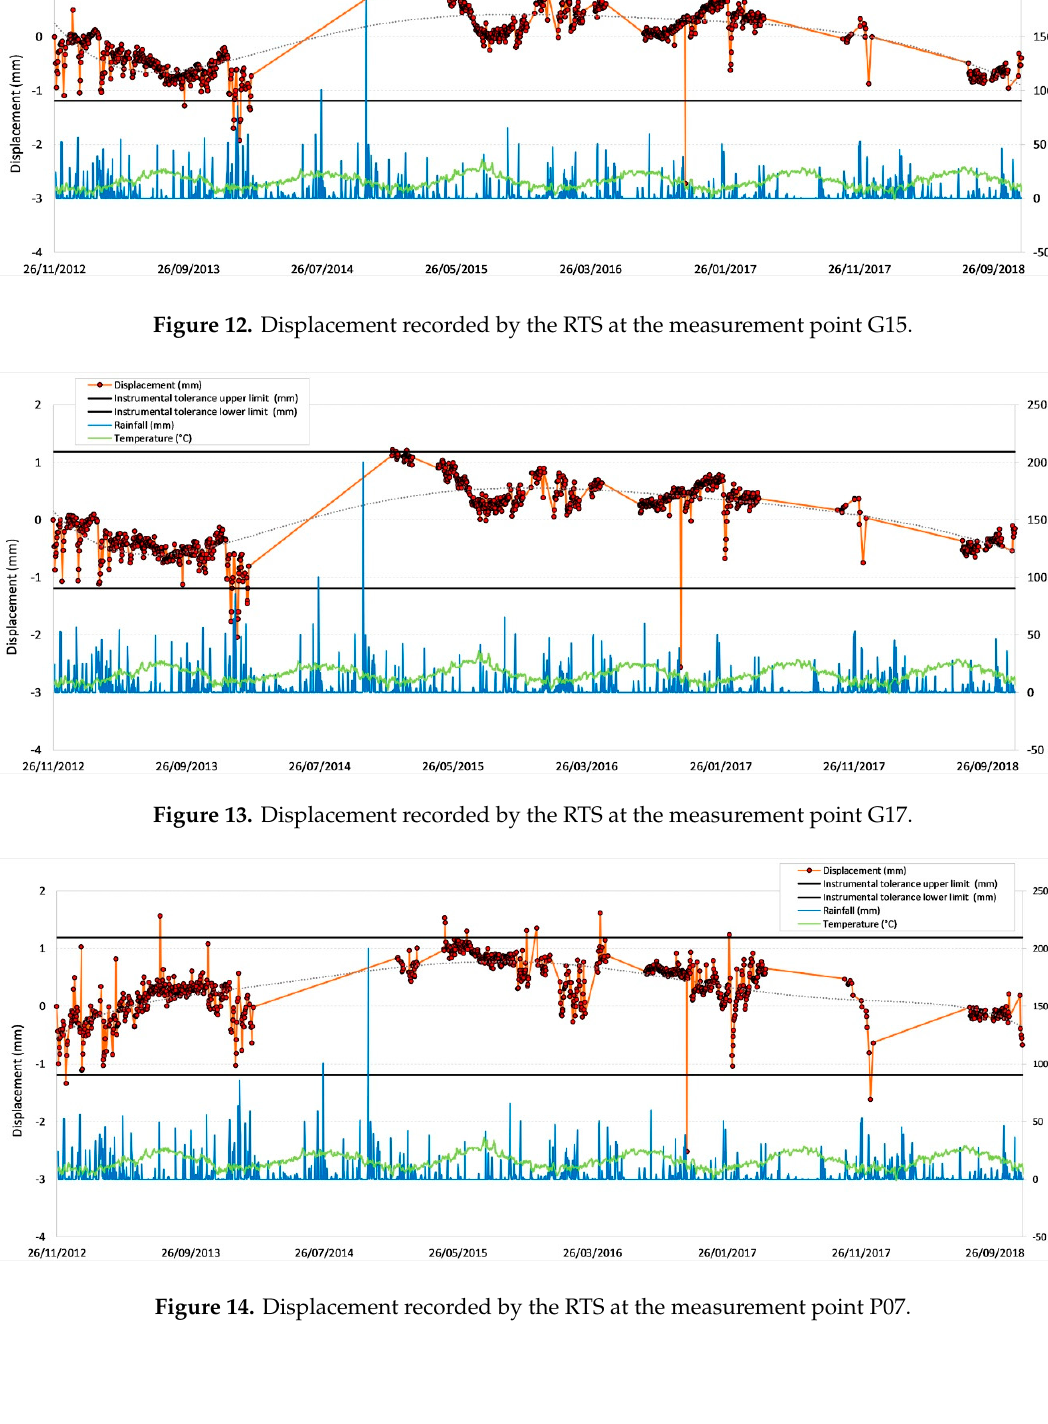
Figure 11. Displacement recorded by the RTS at the measurement point G02 compared to daily average rainfall and temperature. The black lines indicate the instrumental tolerance threshold values.